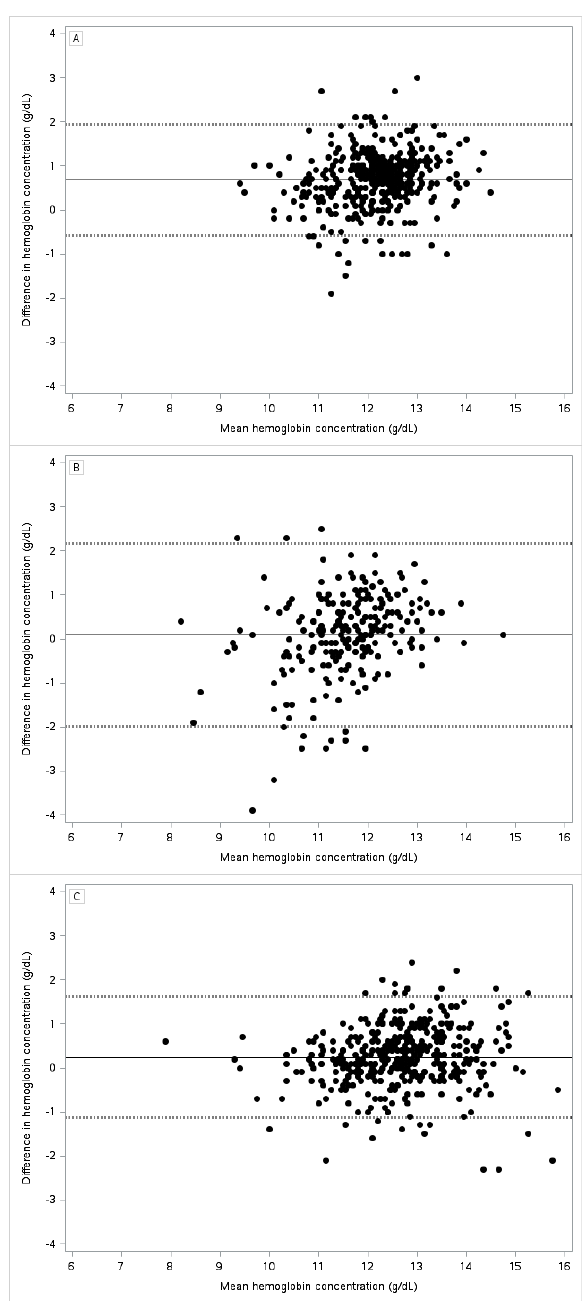
Figure 1. Bland–Altman scatter plots of the difference in hemoglobin concentration from capillary blood analyzed with HemoCue vs. venous blood analyzed with Coulter Counter by the mean of the estimates. Dashed lines represent 95% limits of agreement. Panel ( A ) Kansas City ( n = 413), Panel ( B ) St. Louis ( n = 213), and Panel ( C ) Cleveland ( n = 397).